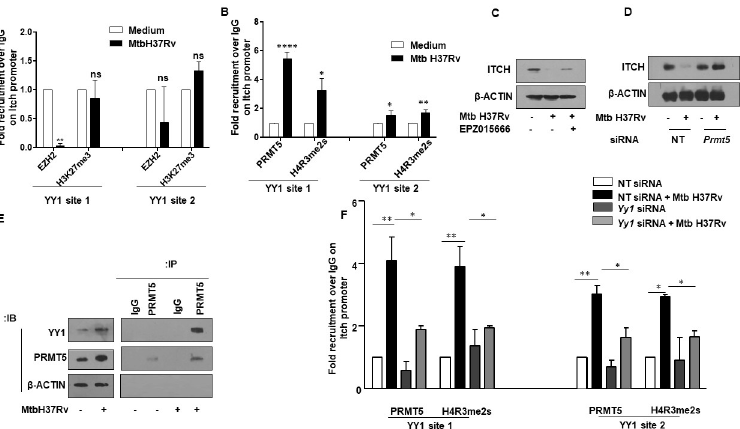
Fig 4. YY1 associates with the arginine methyl transferase PRMT5 to regulate ITCH repression during Mtb infection. (A) Mouse peritoneal macrophages were infected with Mtb H37Rv for 24 h and assessed for the recruitment of EZH2 and associated H3K27me3 marks over the Itch promoter by ChIP assay. (B) Mouse peritoneal macrophages were infected with Mtb H37Rv for 24 h and assessed for the recruitment of PRMT5 and associated H4R3me2s marks over the Itch promoter by ChIP assay. (C) Mouse peritoneal macrophages were treated with PRMT5 inhibitor EPZ015666 for 1 h, followed by 24 h infection with Mtb H37Rv. Whole cell lysates were assessed for the expression of ITCH by immunoblotting. (D) Mouse peritoneal macrophages were transfected with NT or Prmt5 siRNAs. Transfected cells were infected with Mtb H37Rv for 24 h and assessed for the expression of ITCH by immunoblotting. (E) Mouse peritoneal macrophages were infected with Mtb H37Rv for 24 h, whole cell lysates were immunoprecipitated with IgG control or PRMT5 antibodies and assessed for their interaction with YY1 by immunoblotting. (F) Mouse peritoneal macrophages were transfected with NT or Yy1 siRNAs. Transfected cells were infected with Mtb H37Rv for 24 h and assessed for the recruitment of PRMT5 and associated H4R3me2s marks over the Itch promoter by ChIP assay. qRT-PCR data represents mean ± S.E.M. and immunoblotting and ChIP data are representative of three independent experiments. NT, non-targeting; ChIP, chromatin immunoprecipitation. � p < 0.05; �� , p < 0.01; ��� p < 0.001; ���� , p < 0.0001 (One way ANOVA; GraphPad Prism